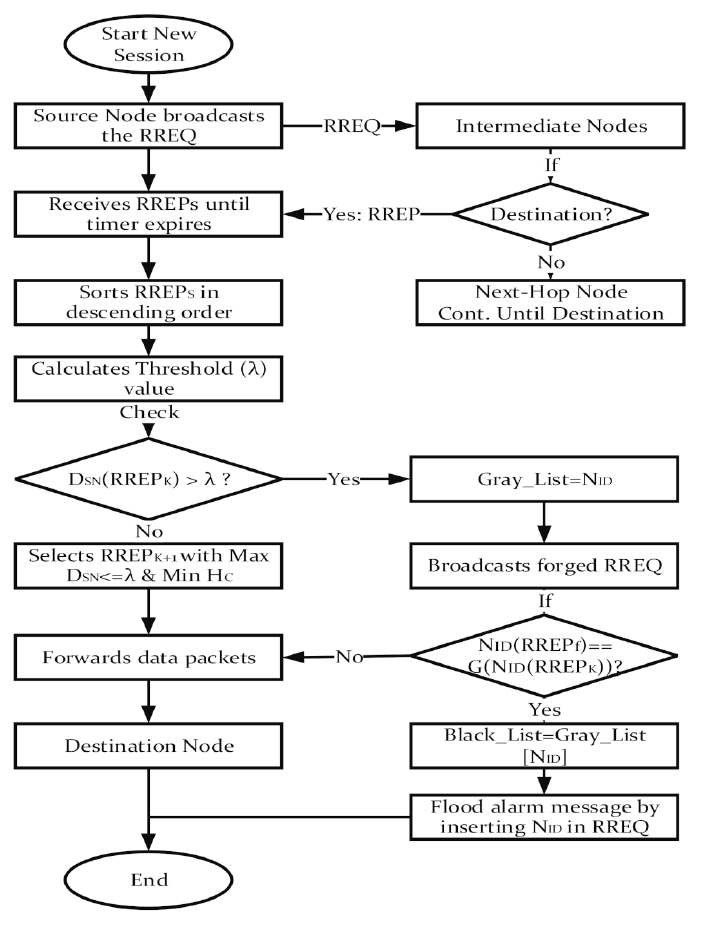
Figure 8. Flowchart of the proposed